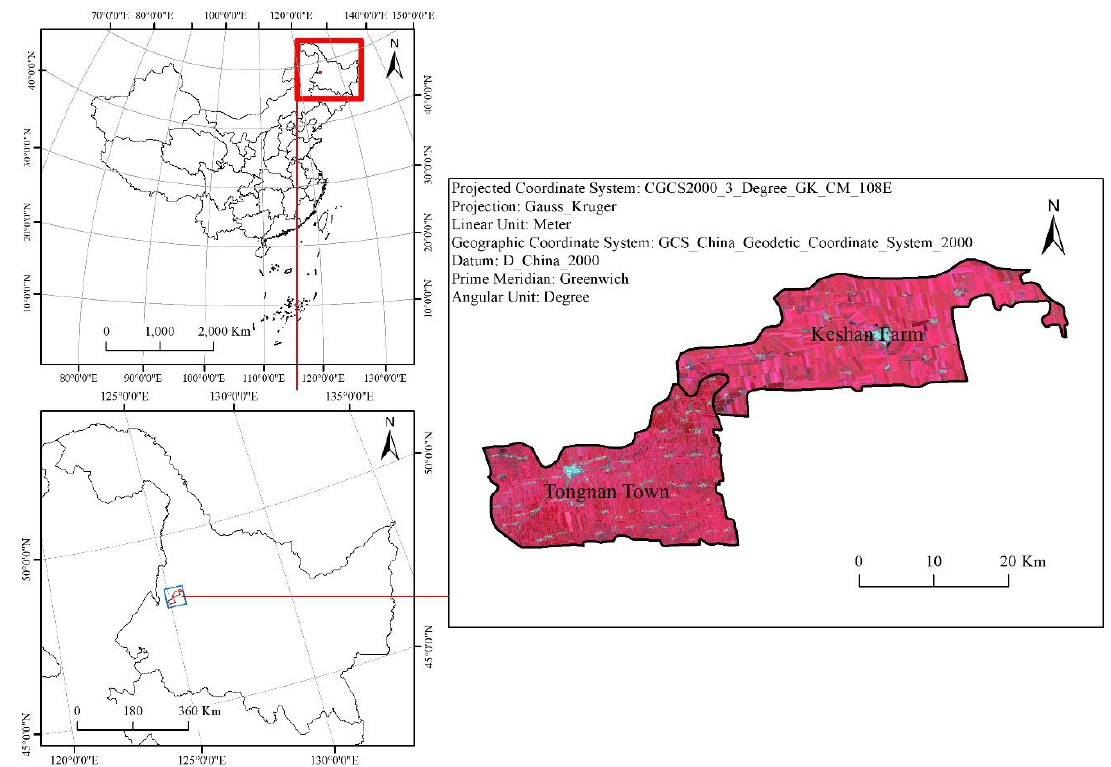
Figure 2. Overview of the study area.